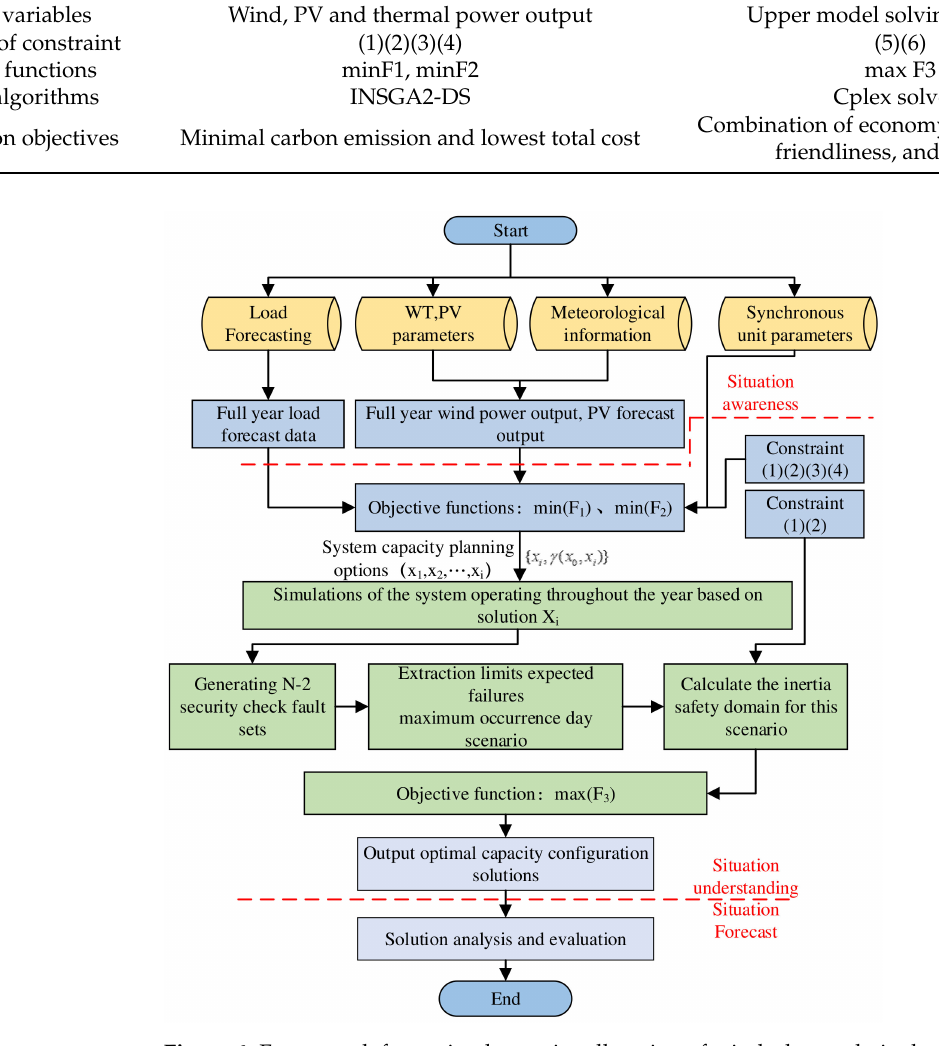
Figure 6. Framework for optimal capacity allocation of wind-photovoltaic-thermal power